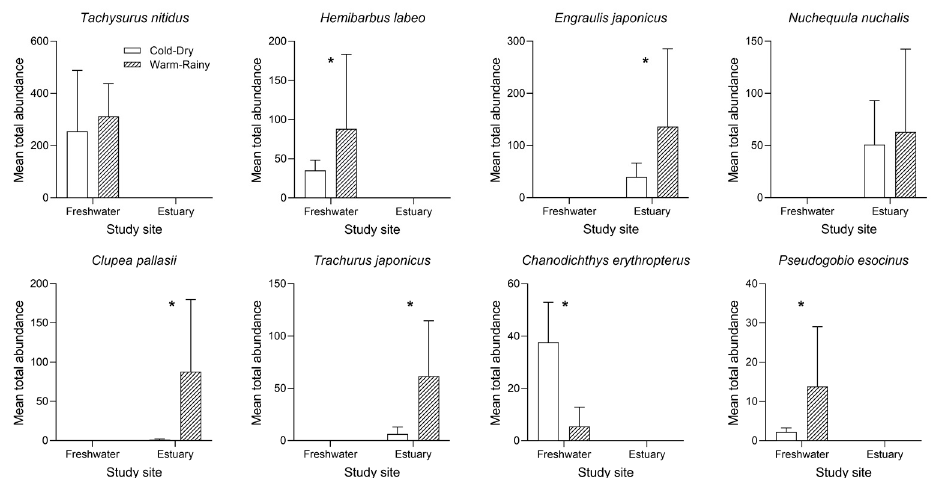
Figure 5. Seasonal variations in mean abundance of 8 common fish species within each freshwater and estuary habitats in the lower Nakdong River, South Korea; asterisks indicate statistical significance at P < 0.05 between seasons within each site.